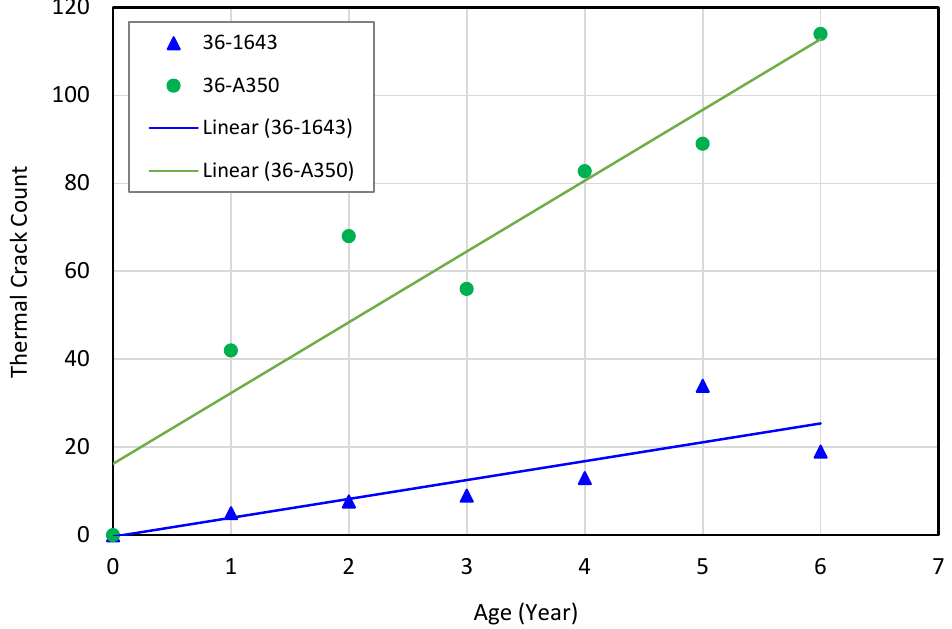
Figure 6. Thermal crack counts on the LTPP test sections located in NY.